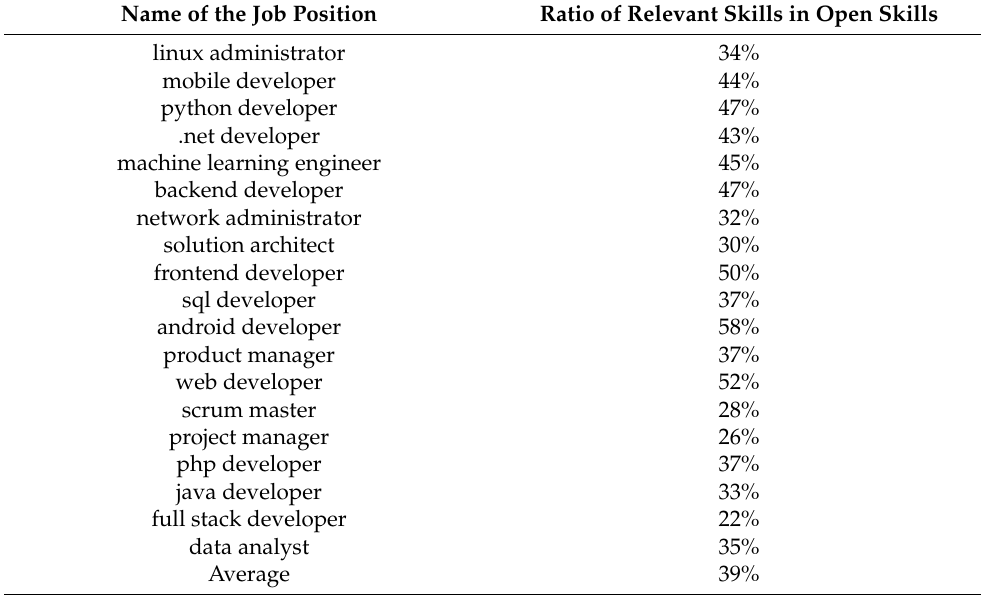
Table 8. The ratio of the found relevant skills in Open